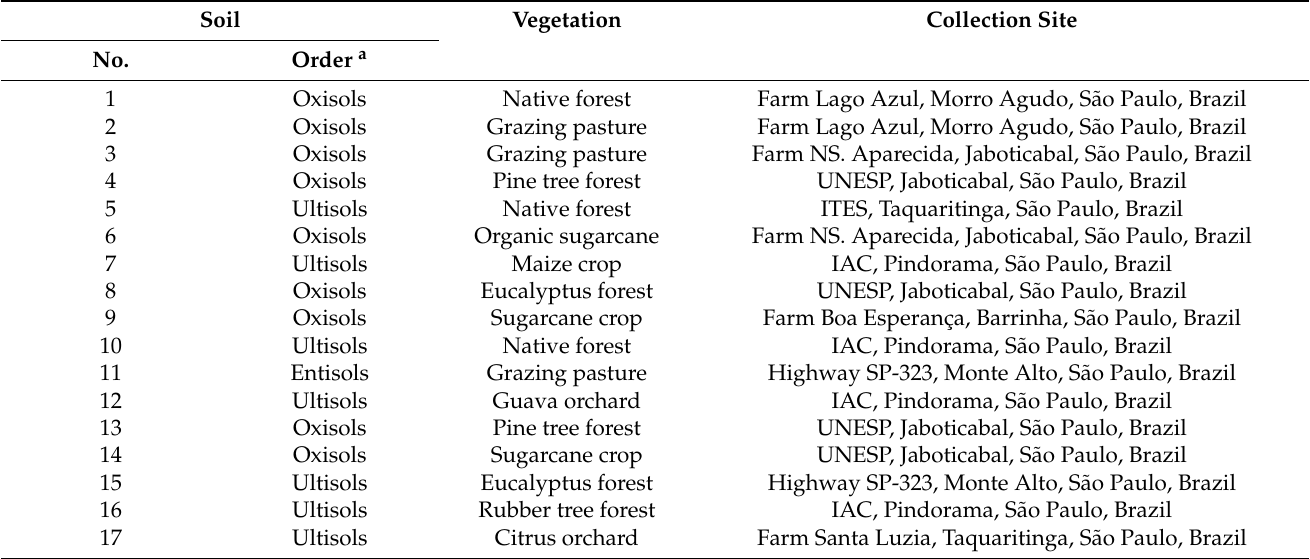
Table 1. Taxonomy, vegetation, and collection sites for soils